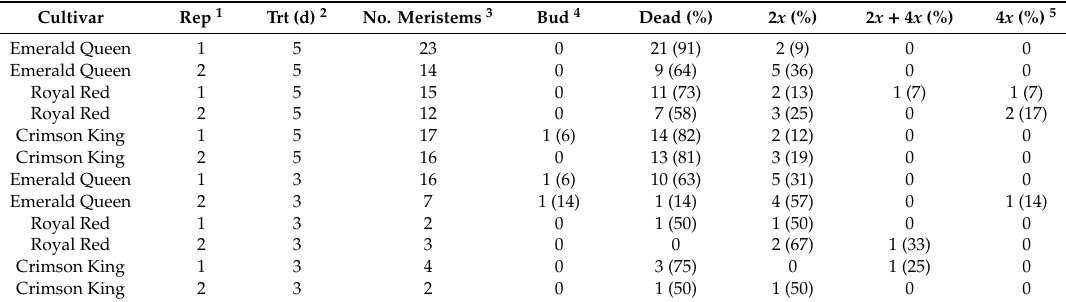
Table 1. Meristems of Acer platanoides (Norway maple) cultivars after treating with 150 µ M oryzalin supplied as Surflan and solidified with 0.8% agar during 2010. Meristems were exposed by removing bud scales and submerging in agar-solidified oryzalin solution for 3 or 5 d. Cultivar Rep 1 Trt (d) 2 No. Meristems